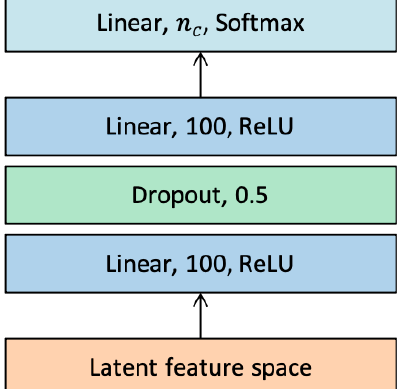
Figure A2. Exact architecture of the